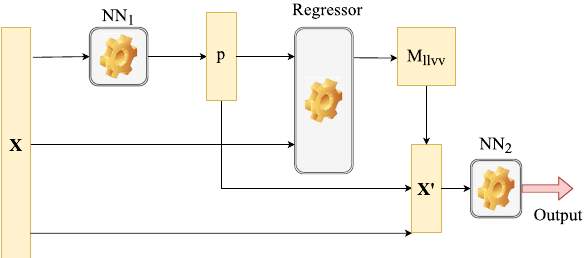
Fig. 7 Flow chart of the combined classification/regression algorithm with stacking – k NNNN for short. All kinematic variables described in Sect. 3 are passed to the Regressor except